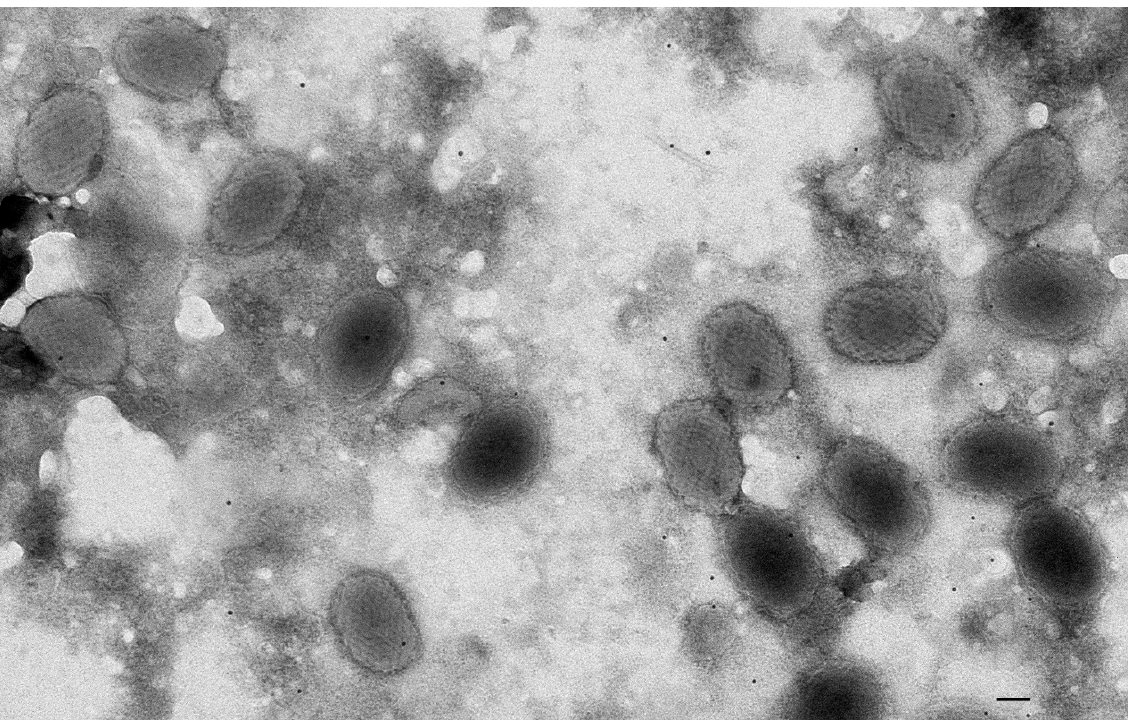
Figure 3. Negative contrast stain transmission electron micrograph displaying SQPV particles in facial skin lesion material from the first confirmed red squirrel squirrelpox case in Gwynedd from Treborth. Bar = 100